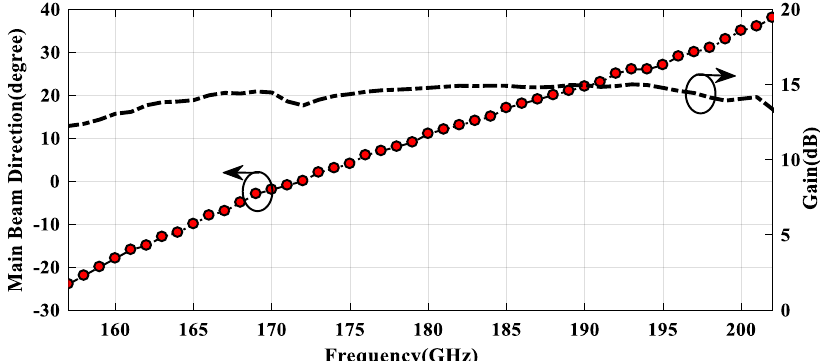
Figure 6. Simulated main beam angles and gain versus frequency.